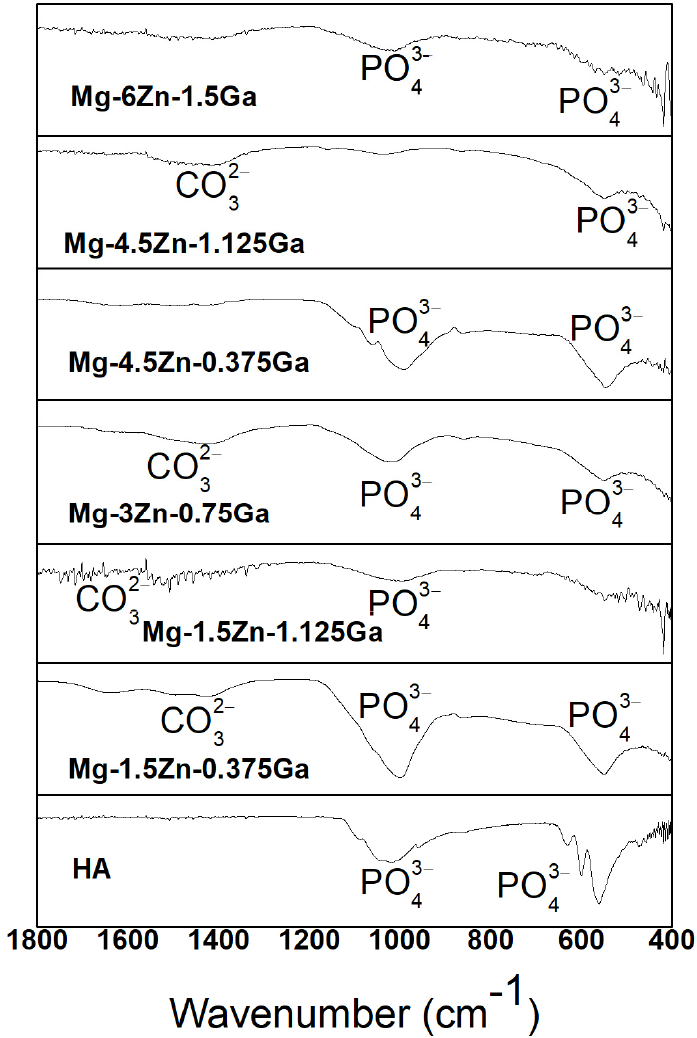
Figure 13. FTIR spectra of HA and the as-cast ternary alloys after 168 h of immersion in SBF.